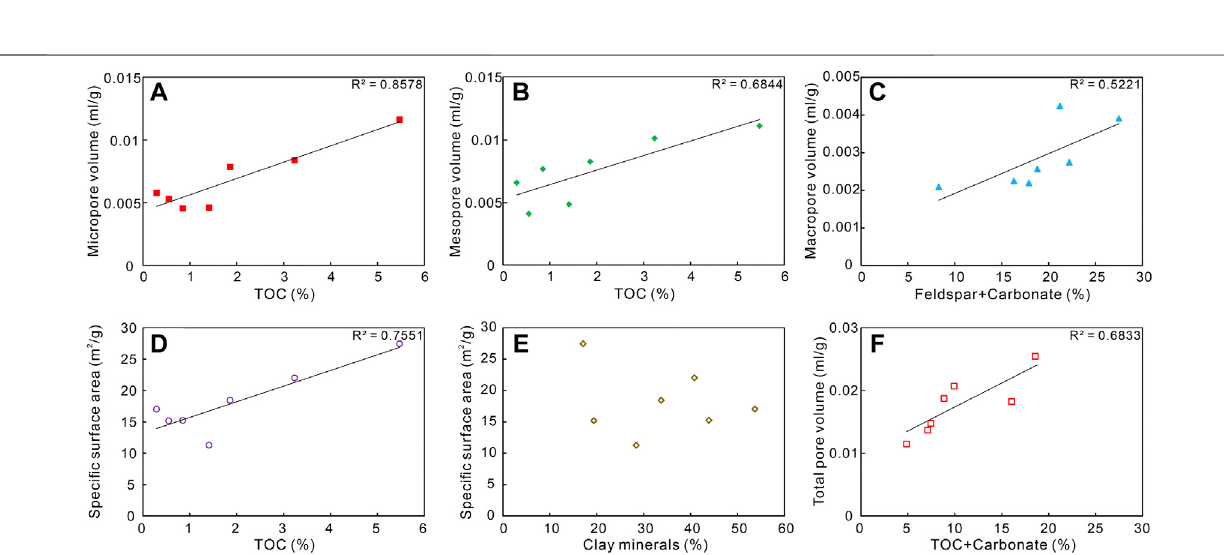
Frontiers in Earth Science |